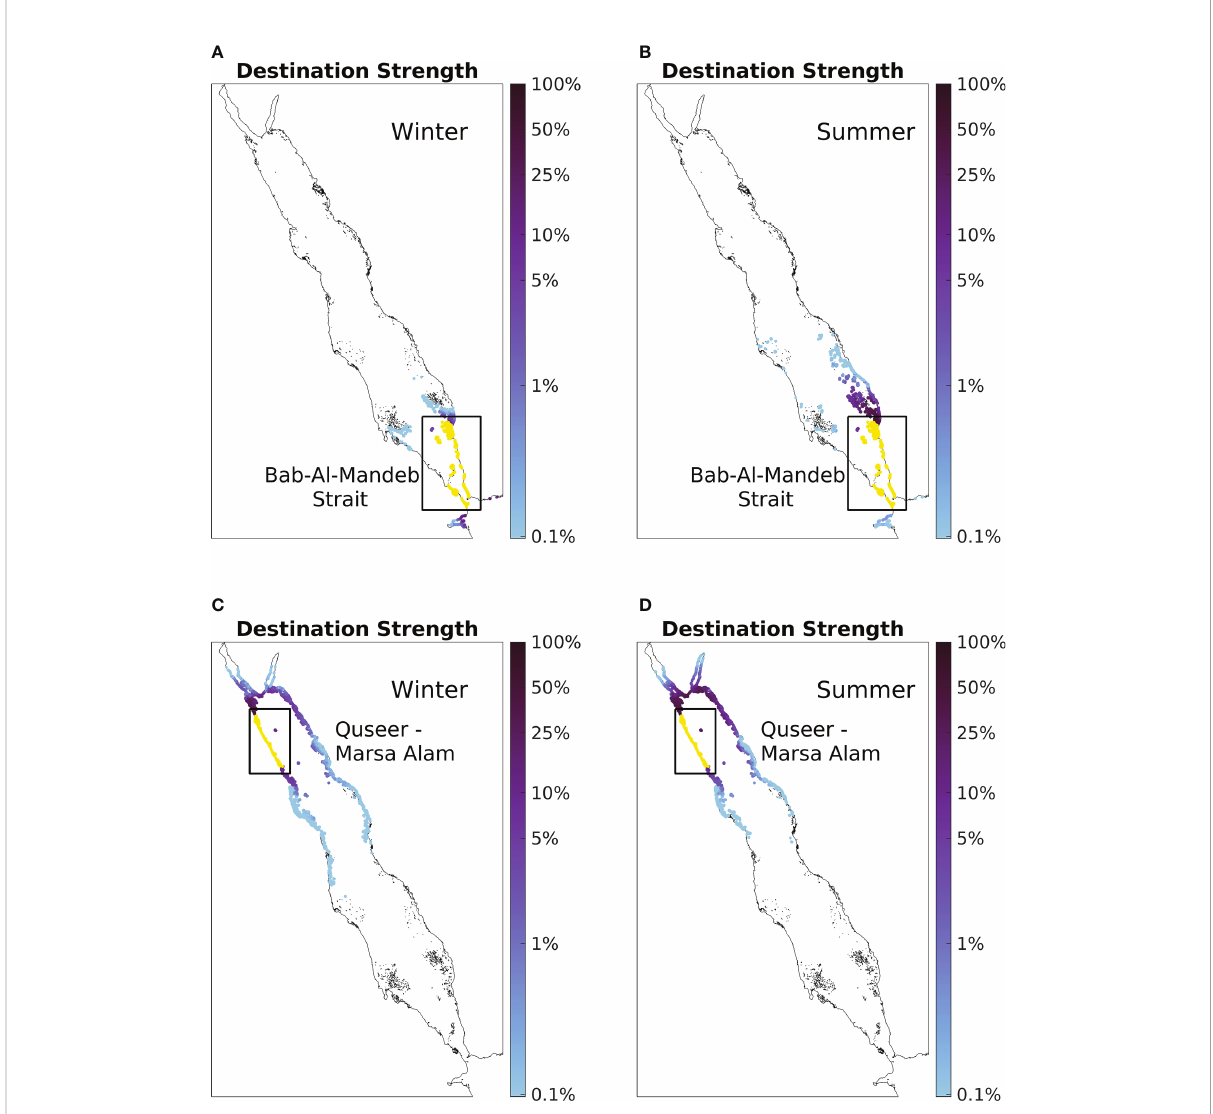
FIGURE 6 Case studies of in fl uenced strength seasonality. (A) Winter destination strength of the BAM strait. Values are calculated based on simulations conducted during winter with particles being released in January and tracked for 30 days. (B) Summer destination strength of the BAM strait with particles being released during summer (in July). Panel (C, D) are the same as panel (A, B) , but for the coastline between Quseer and Marsa Alam instead. Note the logarithmic scale of the